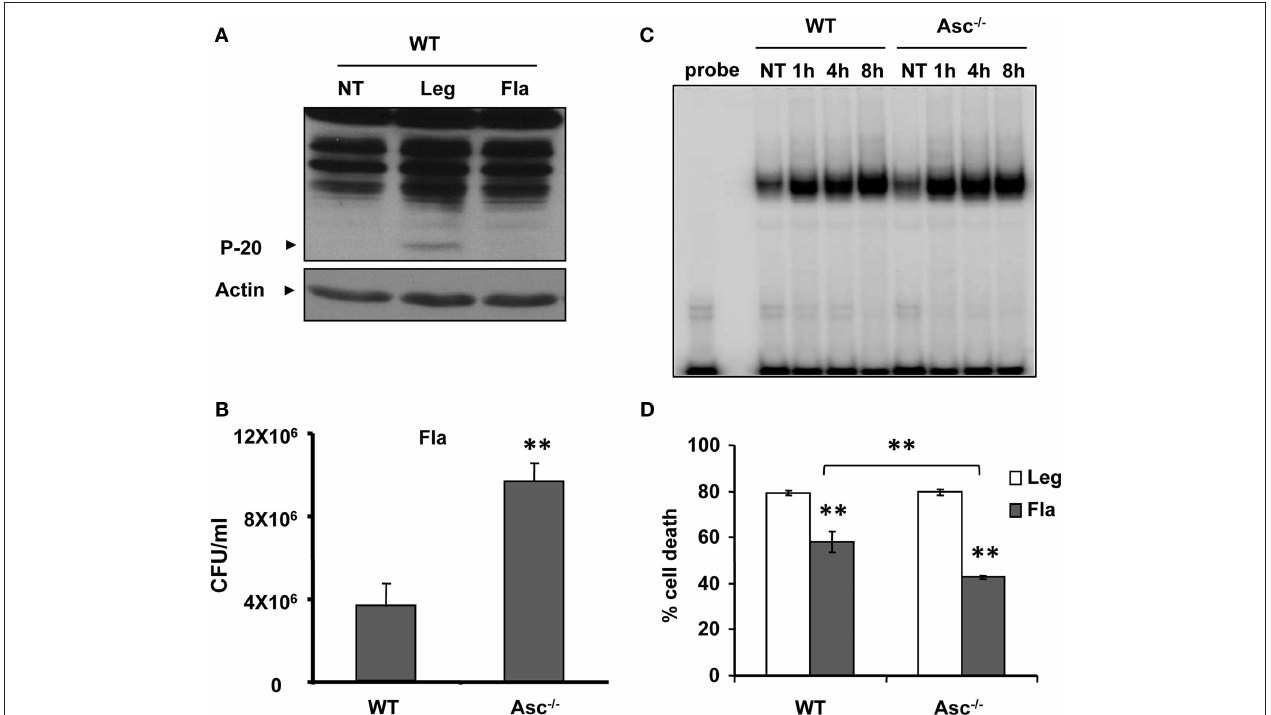
macrophages were infected with Fla mutant for 1, 4, and 8 h then, nuclear extracts were processed for determination of NF- κ B activation using electrophoretic mobility shift assay (EMSA). (D) WT and Asc macrophages were infected with Leg or Fla for 24 h then LDH release was determined and presented as percent cell death on the Y